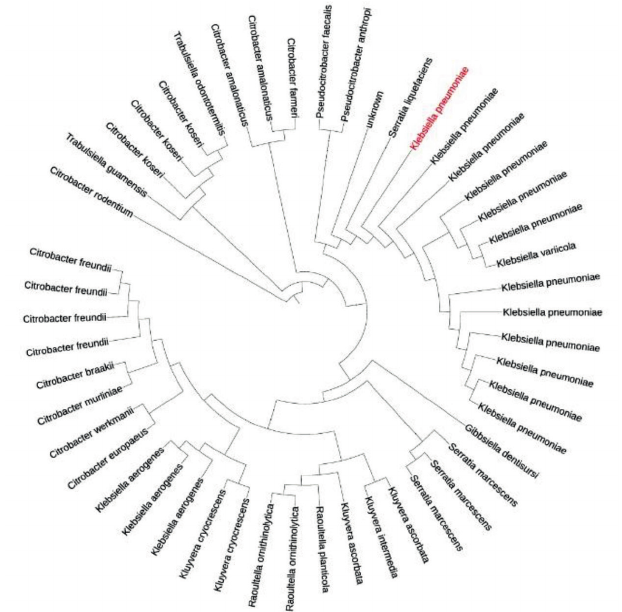
Fig. 3. Phylogenetic analysis of the Klebsiella pneumoniae , isolates with different Klebsiella strains from GenBank